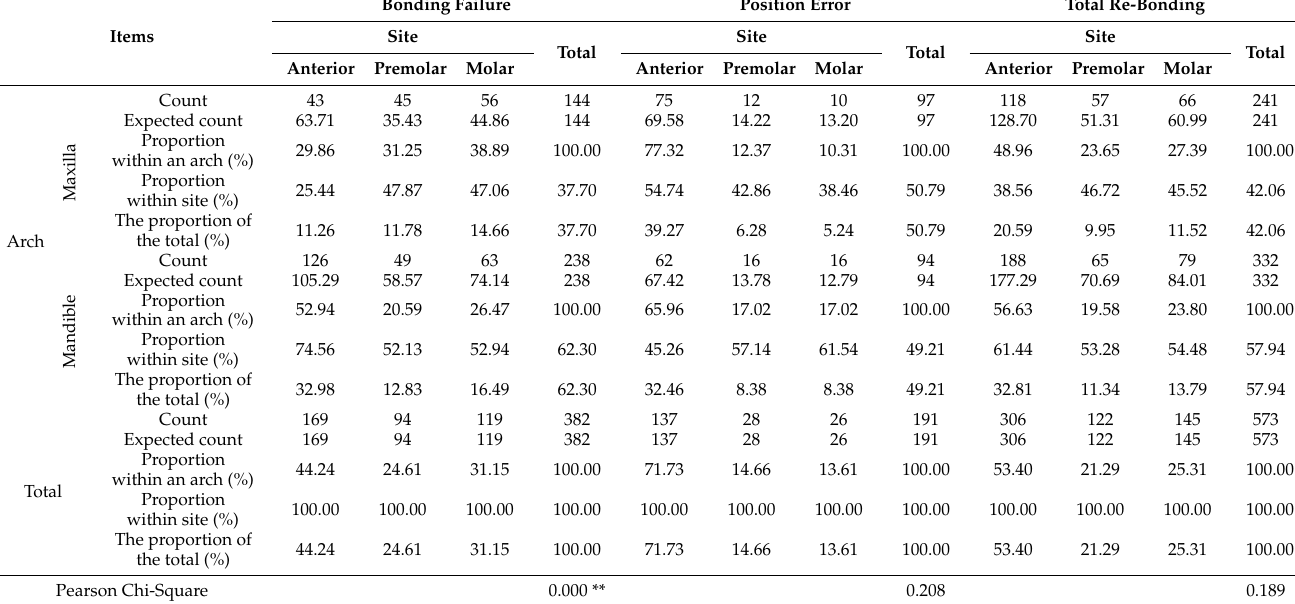
Table 2. Frequency statistics of bracket re-bonding rate in the maxilla and